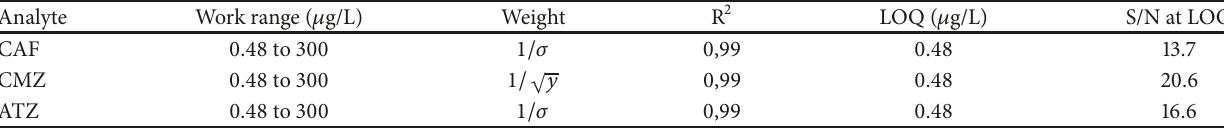
Table 3: Work range and linearity of the external calibration curves.